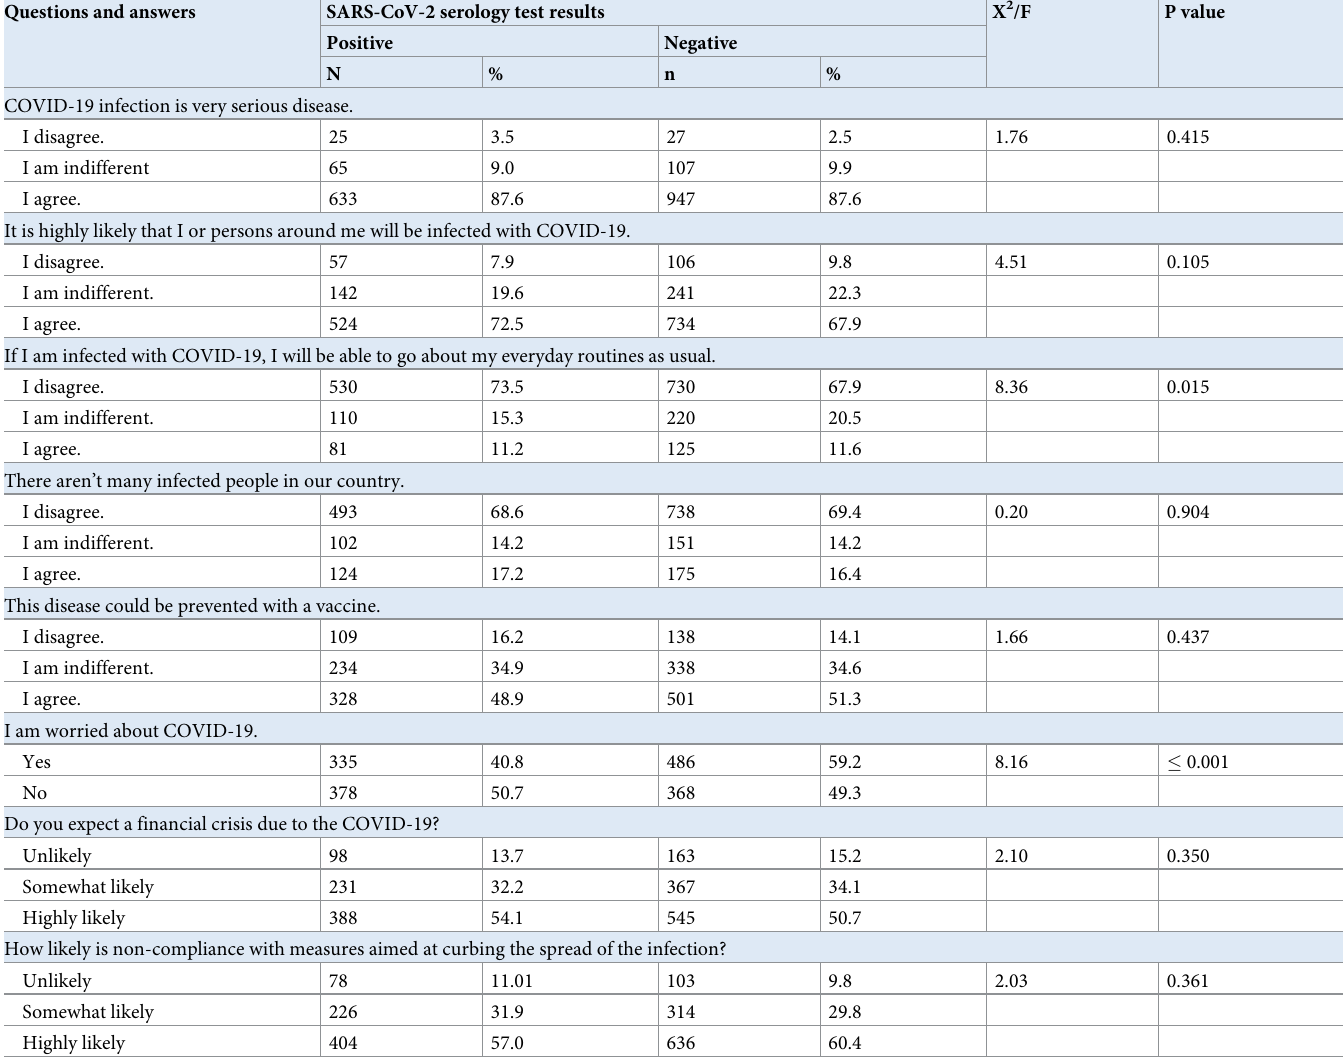
Table 4. People’s knowledge, attitude and practice related to